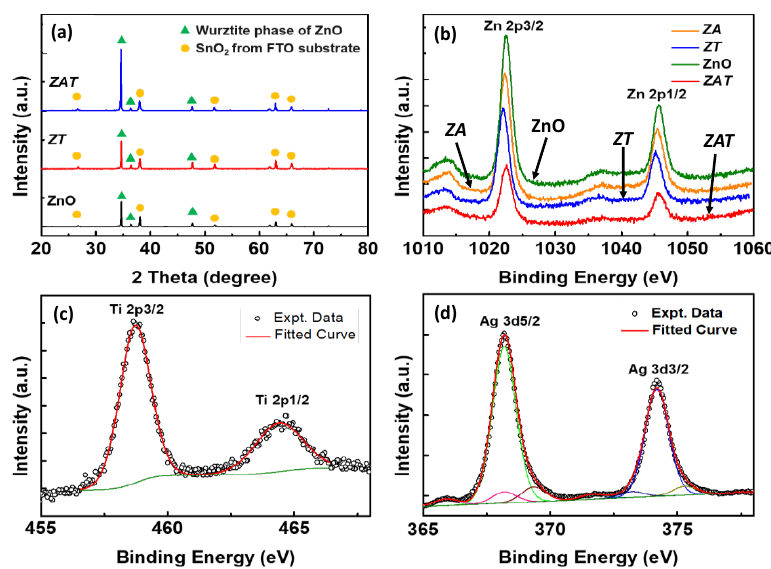
Figure 6. ( a ) XRD patterns of the as-synthesized samples (triangle marks indicate the wurtzite phase of ZnO, solid circles indicate the SnO 2 from the FTO glass); ( b ) XPS spectra of Zn 2p peaks of all four samples (ZnO, ZA , ZT , ZAT ); ( c , d ) experimental and fitted XPS spectra and of (c) Ti 2p of ZT sample and (d) Ag 3d of ZA sample.